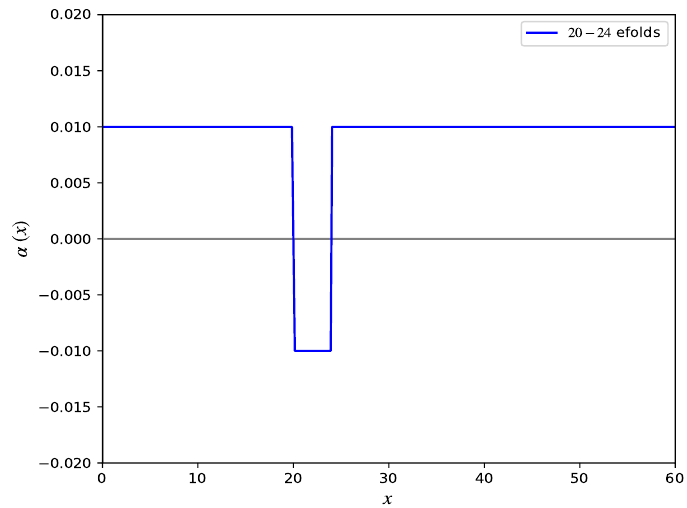
Figure 1 . The plot shows the time-dependence of α with parameters N 1 = 17 , N 2 = 24 and α 0 = 0 . 01 . ∆ N is assumed to be 0 . 01